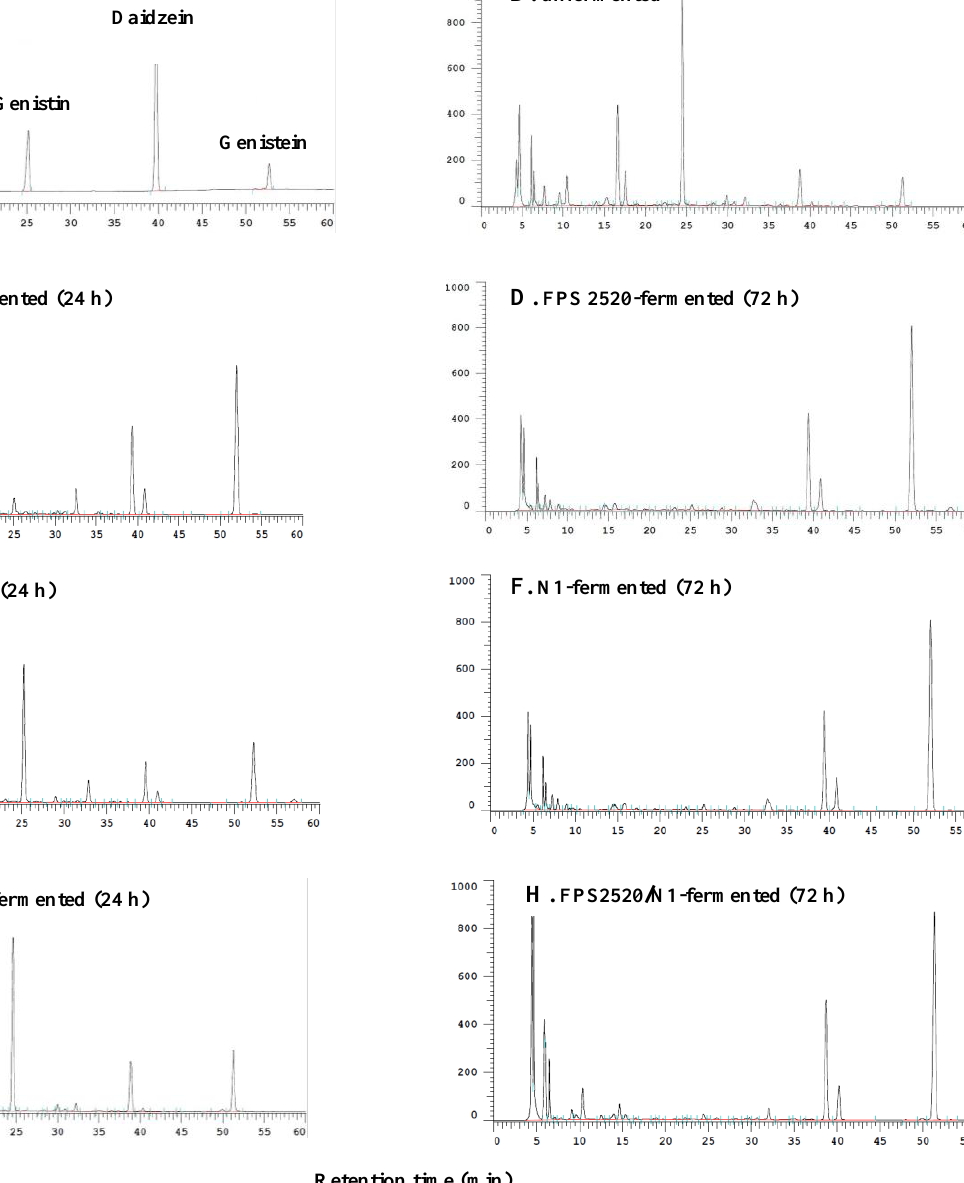
Figure 1. HPLC profiles of ( A ) isoflavone standard, ( B ) unfermented soy bean meal (SBM), SBM fermented by Lactobacillus sp. FPS 2520 for ( C ) 24 h, and ( D ) 72 h, SBM fermented by Bacillus sp. N1 for ( E ) 24 h, and ( F ) 72 h, and SBM fermented by mixed strains for ( G ) 24 h, and ( H ) 72 h.